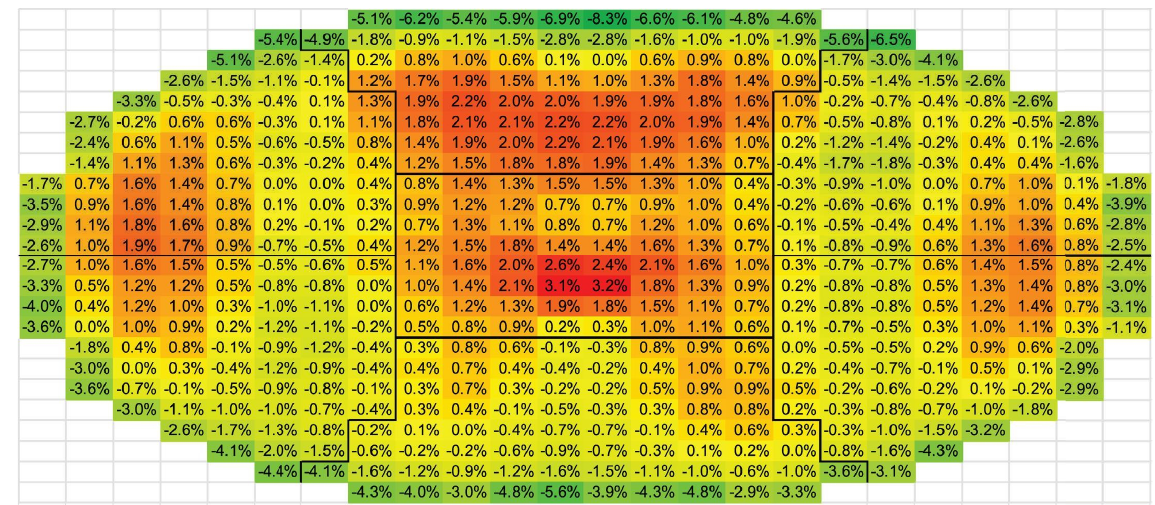
Figure 5: Channel power distribution for TRACE_Mac1.1/PARCS_Mac1.1 model versus SORO error � (PARCS − SORO)/SORO ∗ Table 1: Calculated model initial zone levels versus SORO.